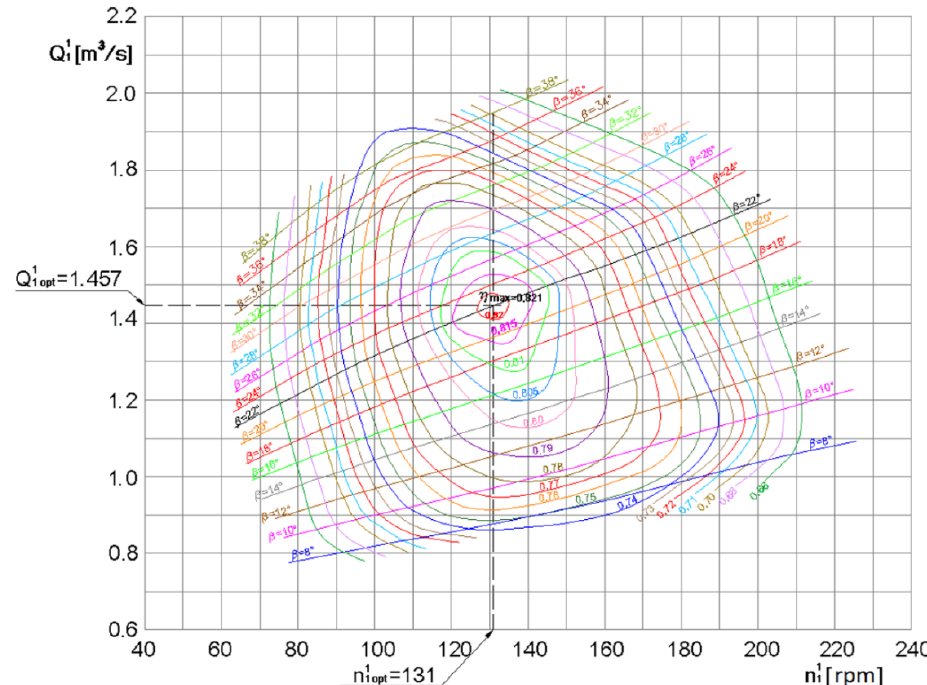
Figure 16. Universal (shell) characteristics of a four-blade vertical semi-Kaplan turbine with a non- classical spiral inflow of water onto the runner, where the efficiency depends on the double-reduced values of the rotational speed and the volumetric flow rate.